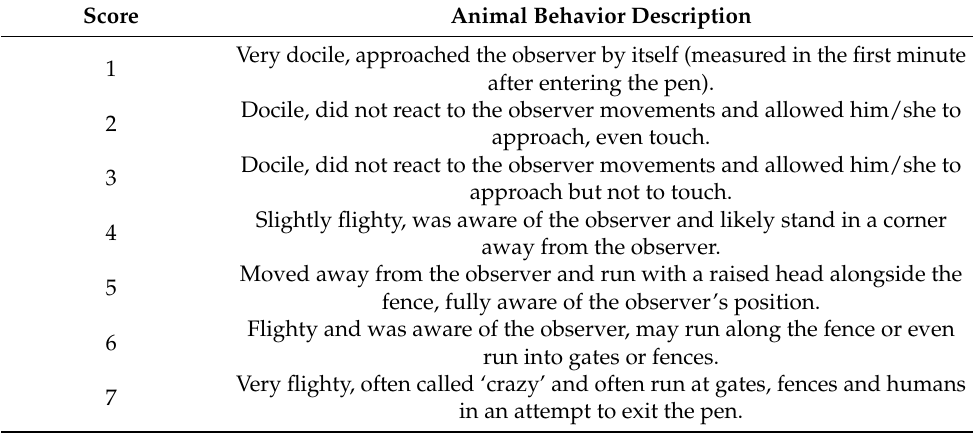
Table 3. Pen score methodology adapted from